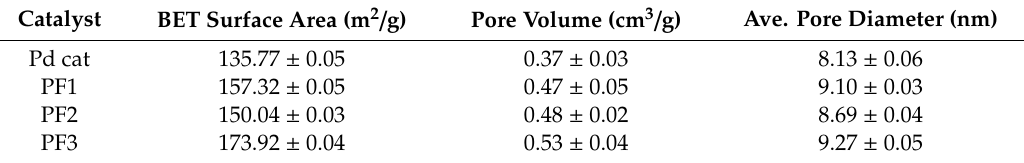
Table 2. Physical properties of catalysts analysed by the Brunauer–Emmett–Teller (BET) method.